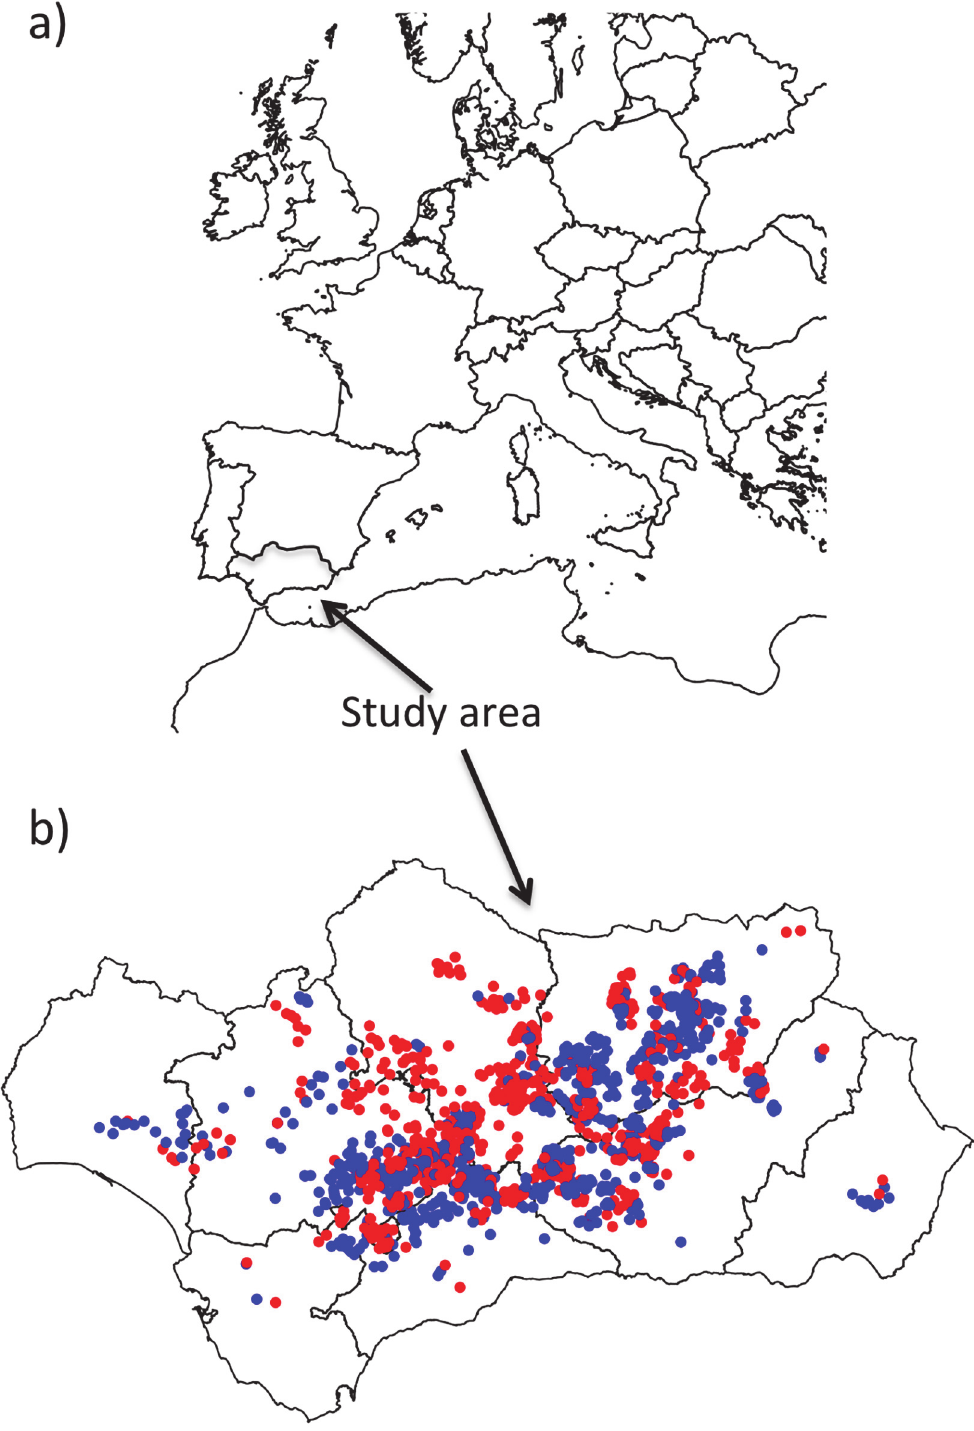
Figure 1. Map of the Andalusian region, Spain, and the monitoring stations used in this study. Red points represent ground cover MS while blue points represent bare soil MS before pairing.